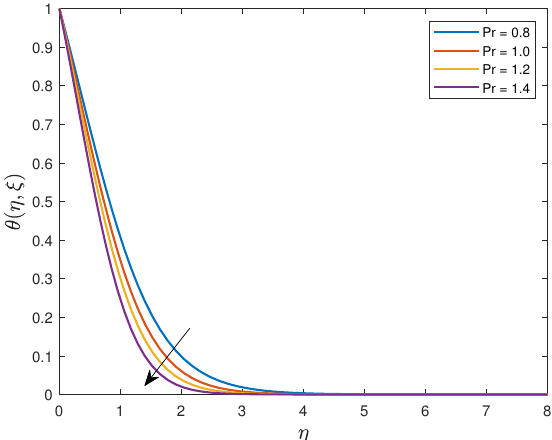
Figure 17. The influence of Pr on fluid temperature.